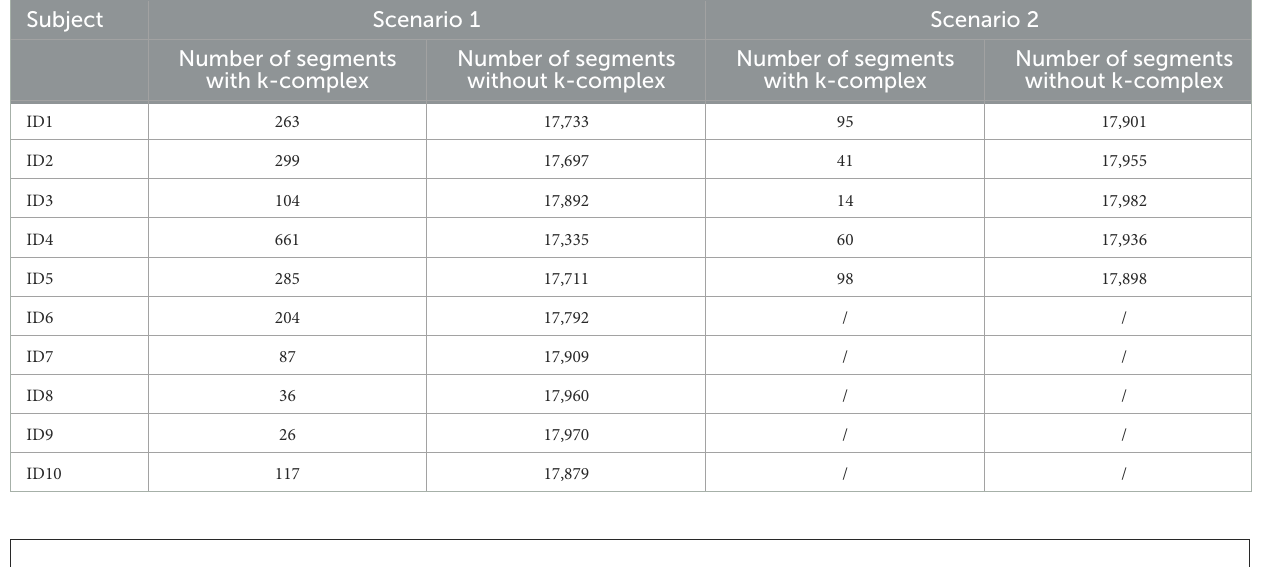
TABLE 1 Number of k-complex in each EEG recording.